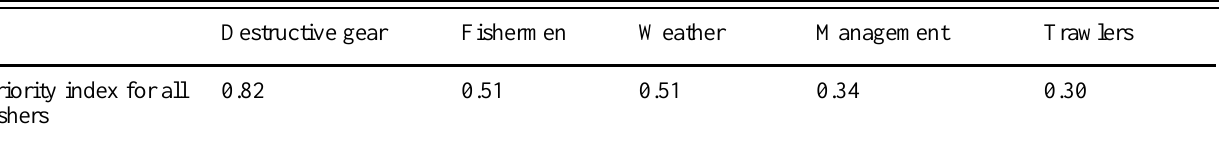
Table 2. Priority ranking of threats to environmental health as perceived by fishers in Mombasa ( n =70) and Diani–Chale ( n